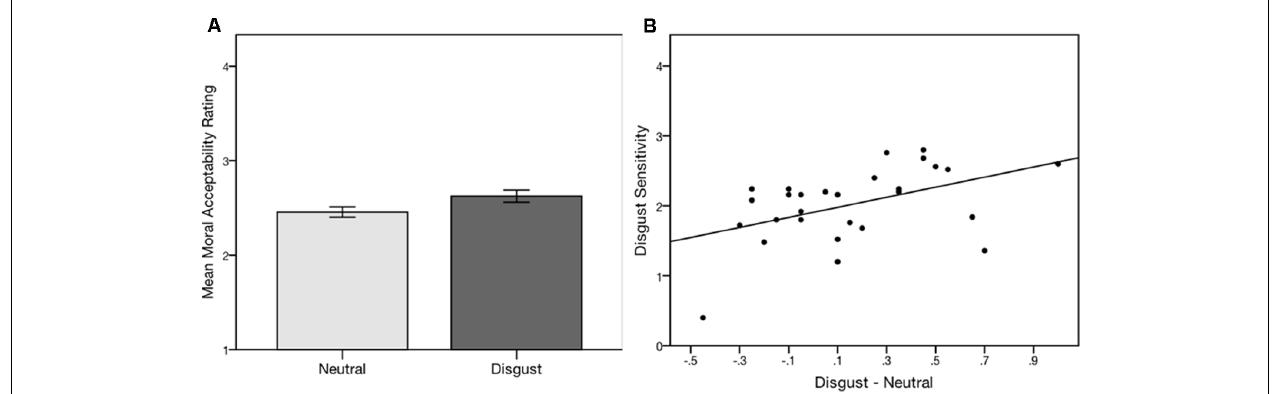
FIGURE 3 | (A) Subliminal disgust priming followed by self-paced screen presentations of moral dilemmas caused subjects to make more utilitarian responses. Error bars represent + / − 1 SE. (B) The degree of influence of the prime (as measured by the difference in mean response in the disgust and